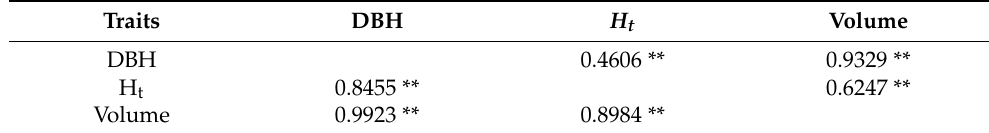
Table 6. Correlation coefficients among the traits of the Paulownia